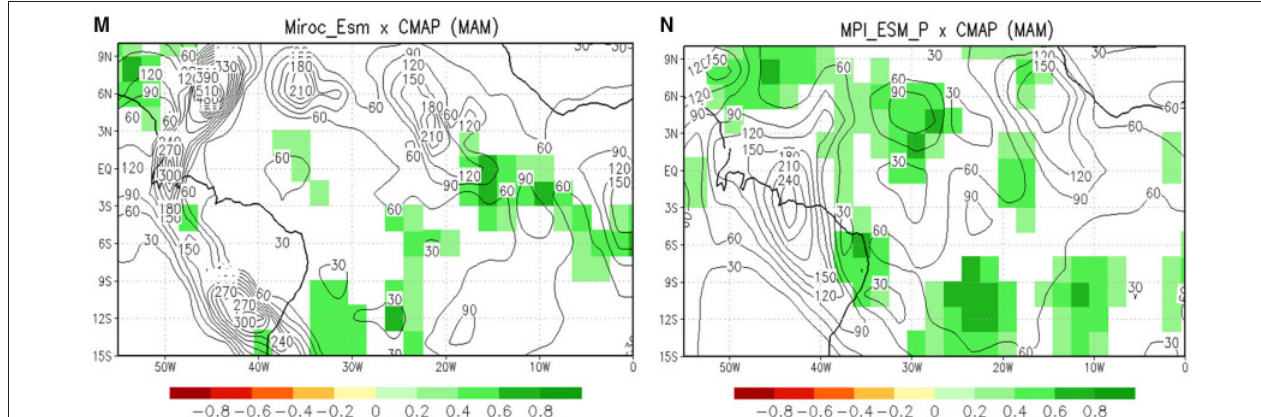
FIGURE 8 | Correlation (shaded) and absolute error (contour in mm/day) to austral autumn (MAM) between observation (CMAP) and simulation from the CMIP5-AR5 models for period 1979–2000. The models considered are: (A) Access1_0, (B) Bcc_ems_1_1, (C) Bcc_ems_1_1_n, (D) BNu-Esm, (E) Cesmi_Fastchem, (F) Cncrm_cms, (G) Ec_Earth, (H) Iap_goals_s_2, (I) Fio_Esm, (J) Gfdl_Esm2g, (K) Giss_e3_r_ce, (L) Hadgem2_Es, (M) Miroc_Esm, and (N) MPI_ESM_P. Green areas indicate statistical significance of the correlation at 95% according to the Student’s t -test.